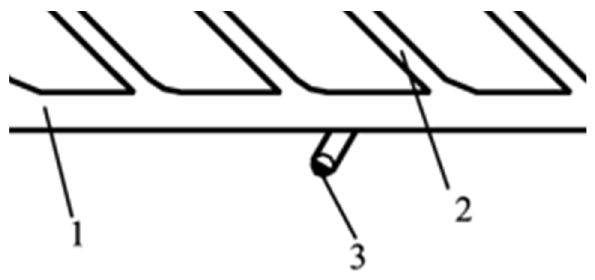
Figure 10. The roadway map (a part) of our engineering project. 1: outlet roadway; 2: mining route; 3: jack shaft. 3: jack